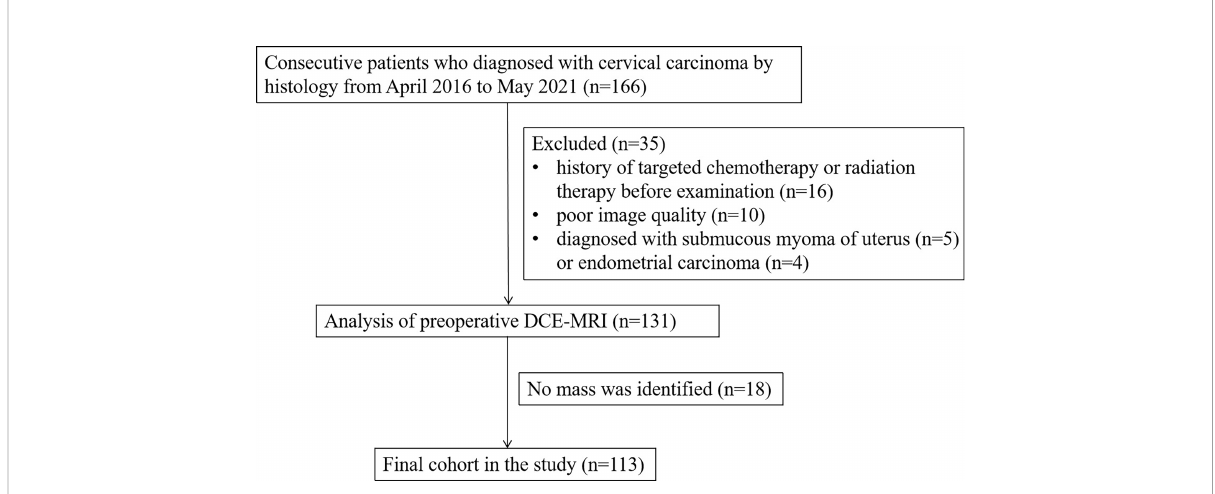
FIGURE 2 Flowchart of patient population.